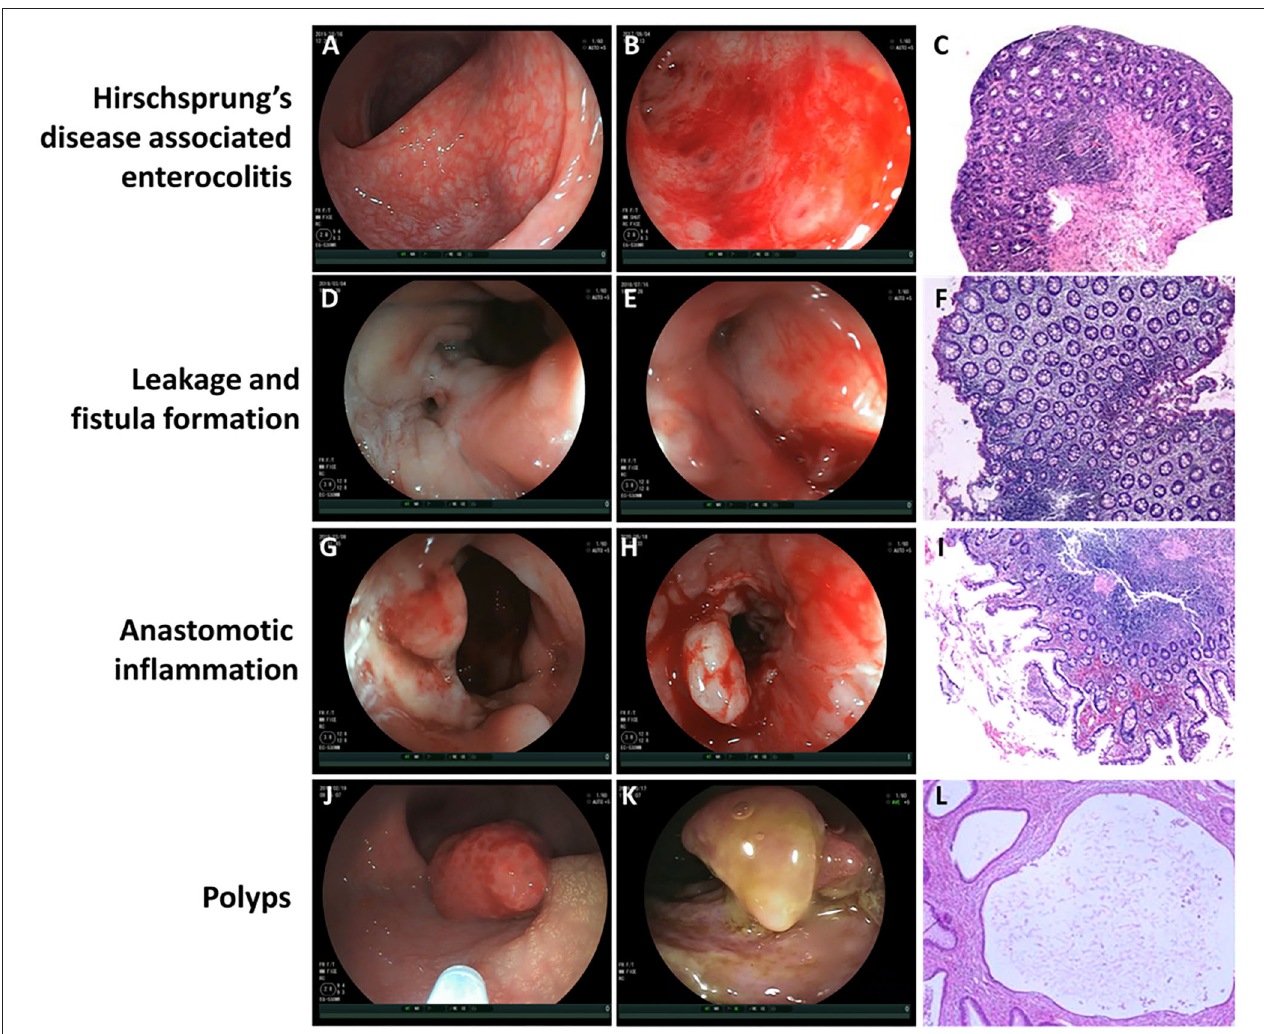
FIGURE 1 | The visual finding of colonoscopy and pathological changes under microscope. (A) Extensive congestion and mucosal edema of the colon and neorectum in patients with Hirschsprung’s disease associated enterocolitis (HEAC). (B) Mucosal ulceration and bleeding with mucosal annular protrusion and mucosal ulcer formation in patients with HAEC. (C) Extensive chronic inflammation in colonic and rectal mucosal tissues with mucoid and inflammatory effusion under microscope. Magnification × 100. (D) Fistula formation near the anastomotic leakage. (E) Mucosal edema and congestion around the leakage. (F) Chronic inflammatory cell infiltration and focal erosion in the intestinal mucosa under microscope. Magnification × 100. (G) Mucosal erosion, edema, and bleeding near the anastomotic site in patients with anastomotic inflammation. (H) Mucosa was locally uplifted and brittle, and bleeding was obvious after scratching in patients with anastomotic inflammation. (I) Chronic infiltration of inflammatory cells in the mucosa near the anastomotic site, accompanied by focal hemorrhage and extensive erosion under microscope. Magnification × 100. (J) Juvenile polyp. (K) Inflammatory pseudopolyp. (L) Focal areas of mucosal hyperplasia with cystic dilatation of the crypts and accumulation of mucus within the cysts under microscope (Juvenile polyp). Magnification ×